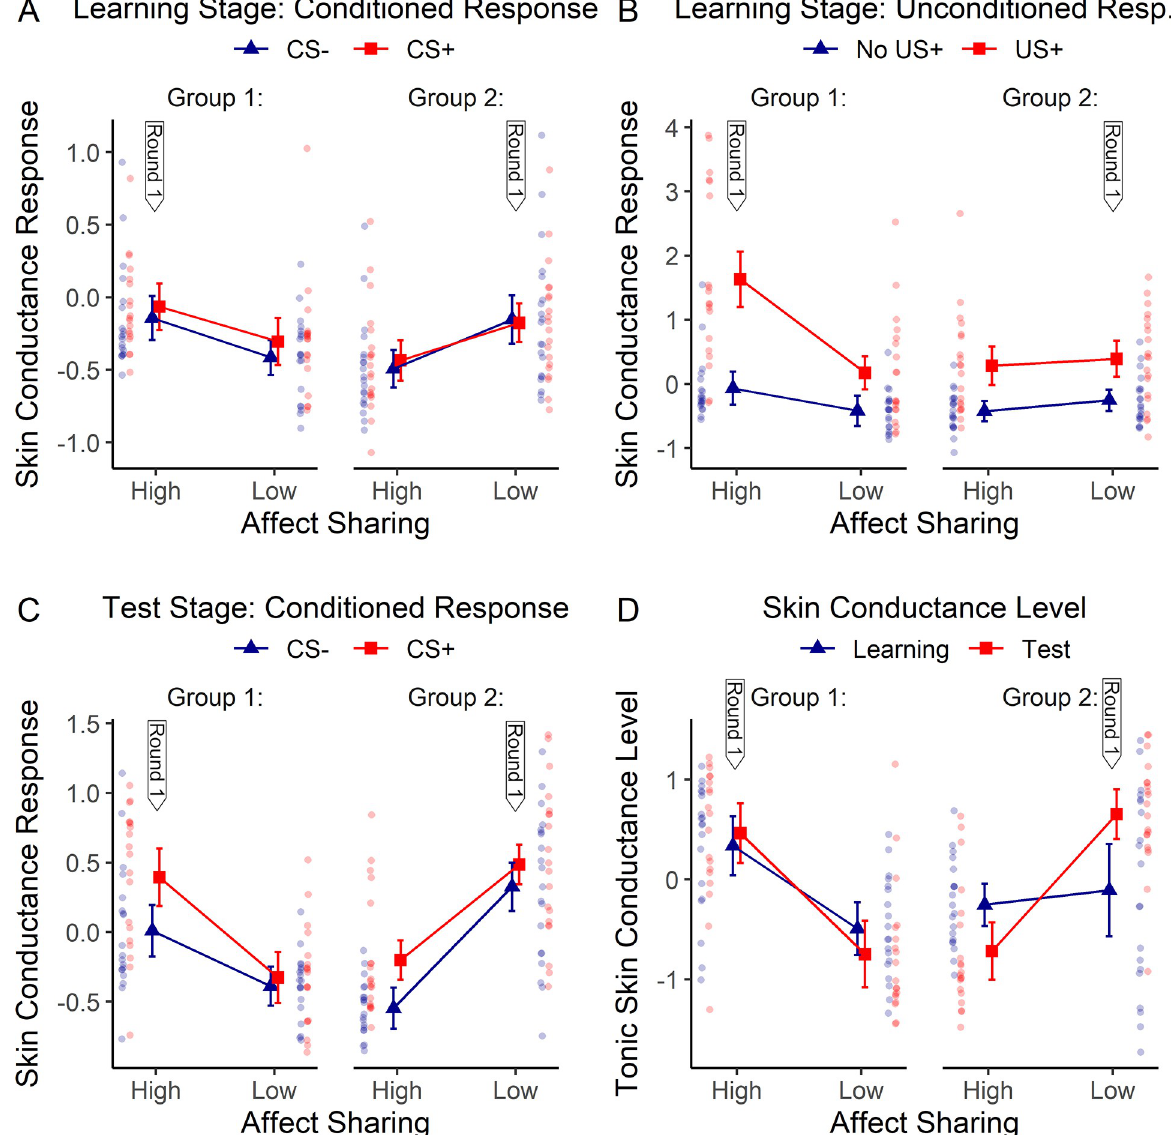
Fig 3. Effects of hypnotic suggestions for high versus low affect sharing on skin conductance response (SCR) (panel A, B, C) and tonic skin conductance level (SCL) (panel D), shown separately for the two groups receiving the high affect sharing condition in round 1 (group 1) or in round 2 (group 2). The thick vertical arrows (“Round 1”) indicate which suggestion was delivered first in this group. Results are expressed as z- scores. A) SCR to seeing the colored square (CS+ or CS-) in the learning stage. B) SCR to seeing the demonstrator receive shocks (US+) or no shocks (No US+) in the learning stage. C) SCR to seeing the colored square (CS+ or CS-) in the test stage. D) Tonic SCL in the learning and test stage. Error bars reflect 95% confidence intervals corrected for within-subject designs (see Methods). Results of individual participants are shown laterally as semi-transparent